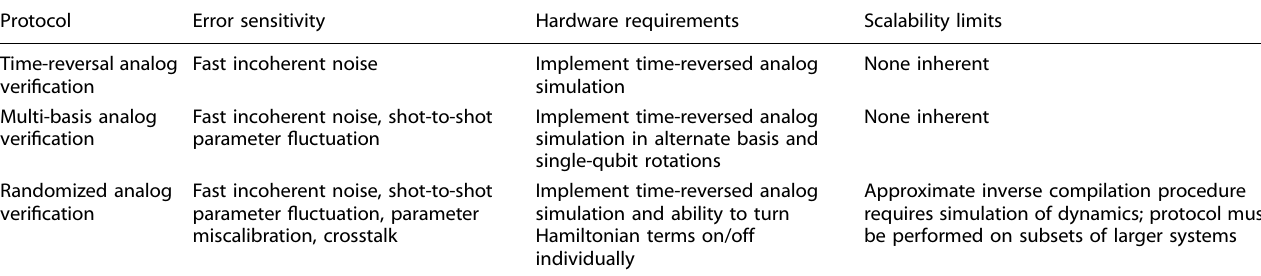
Table 1. Summary of characteristic error sensitivity, hardware requirements, and scalability limits for proposed veri fi cation protocols for analog quantum